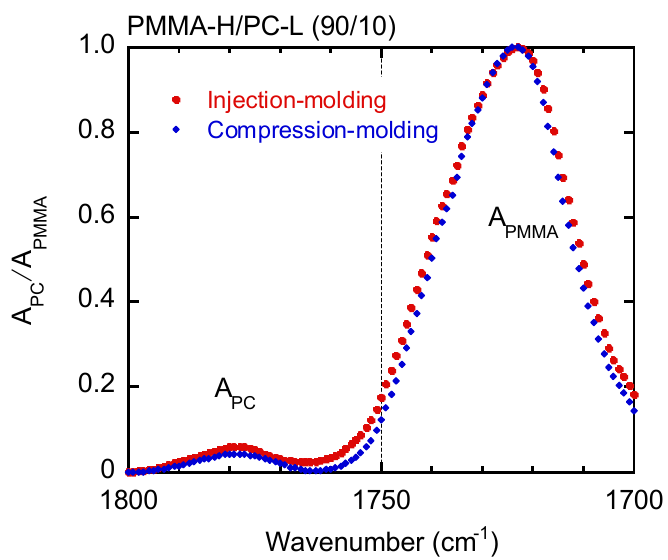
Figure 8. Normalized ATR-IR spectra of PMMA-H/PC-L (90/10) samples prepared by (circles) injec- tion molding and (diamonds) compression molding.